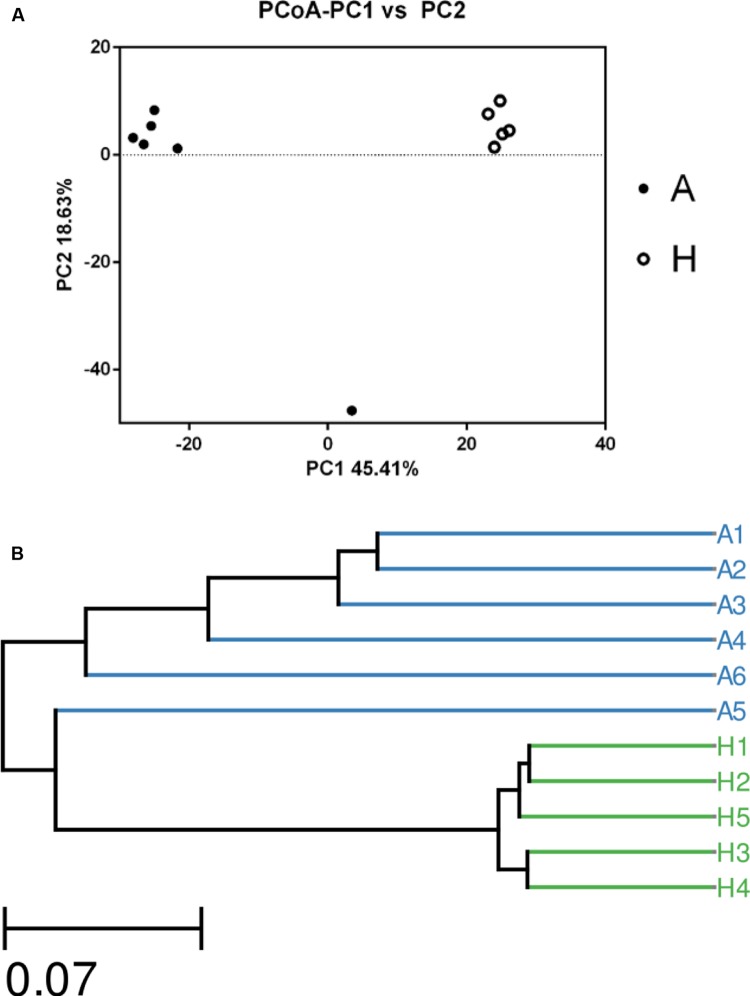
The Principle component analysis (PCA) (A) and UPGMA Method of Beta diversity index (B) of groups A and H.